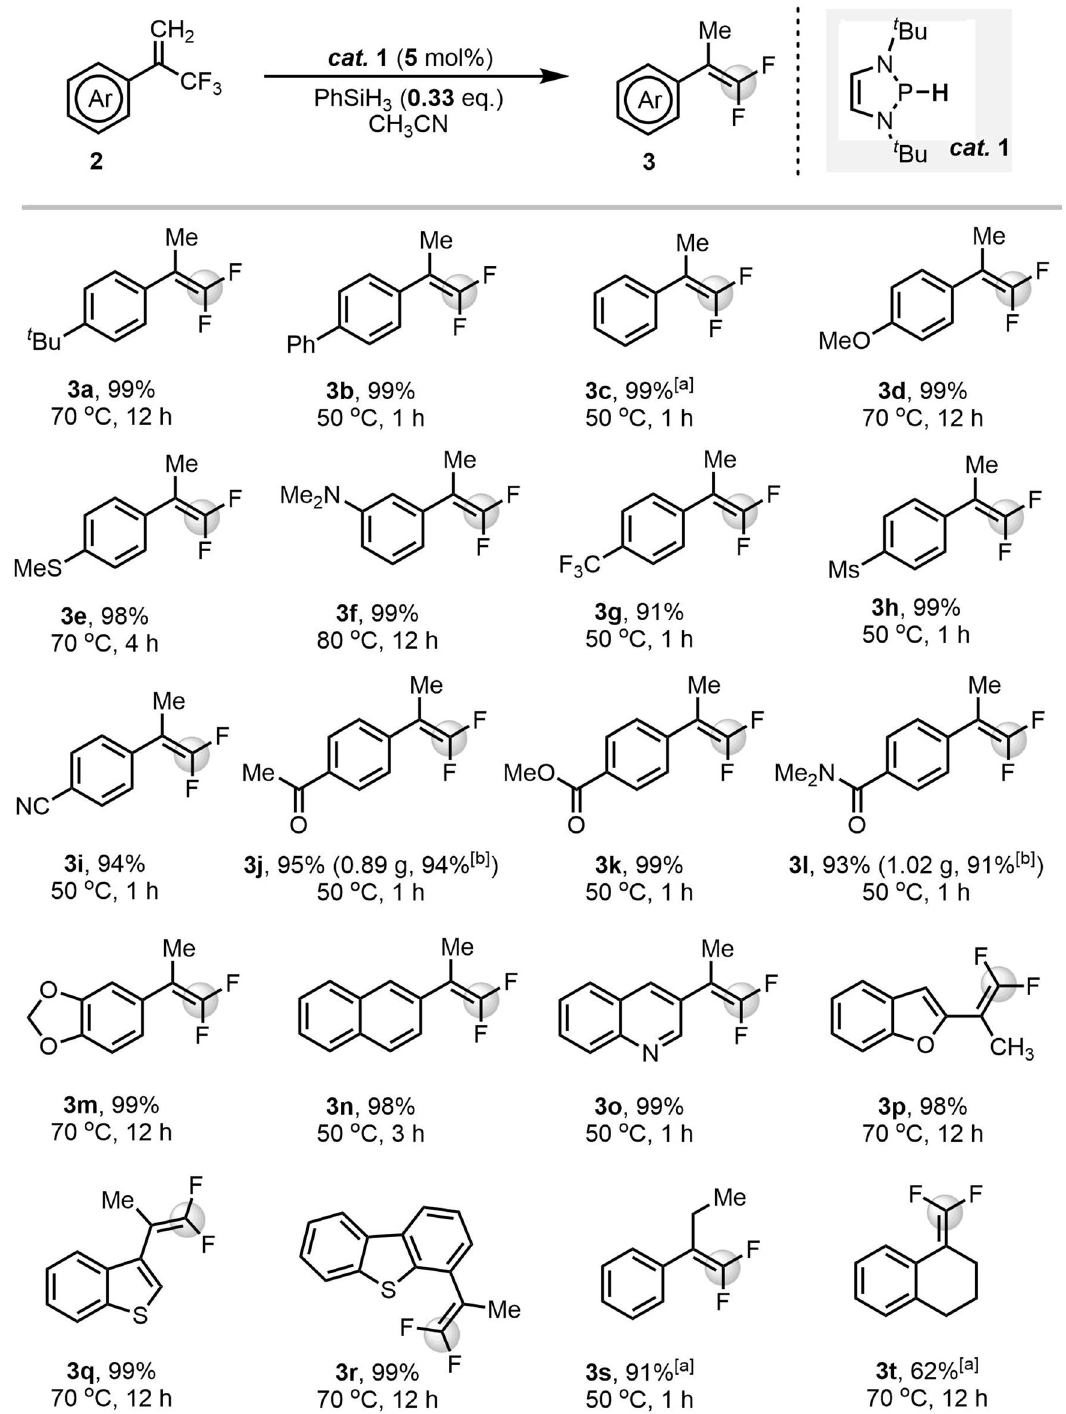
Fig. 4 Synthesis of gem -di fl uoroalkenes by diazaphospholene-catalyzed HDF of tri fl uoromethylalkenes. General reaction conditions: 2 (0.3 mmol), 1 (5 mol%), PhSiH 3 (0.33 equiv.) and CH 3 CN (1 mL) were mixed in a tube under Ar. Isolated yields were given. [a] Determined by 19 F NMR spectroscopy. [b] Isolated yields for gram-scale synthesis: 2j or 2 l (5.0 mmol), 1 (5 mol%), PhSiH 3 (0.33 equiv.), CH 3 CN (5 mL), 50 o C, 3